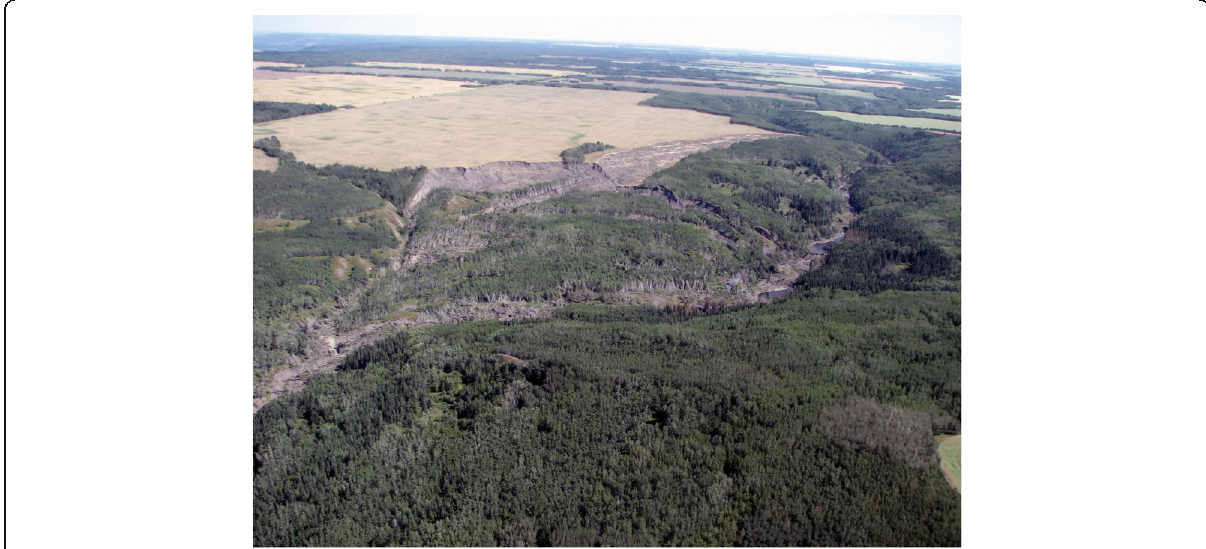
Fig. 7 Oblique air photo of the 2007 Fox Creek landslide, dam and lake, looking upstream. Note that much of the timber atop the landslide remained upright. (Source: Alberta Geological Survey, 2009; reproduced with